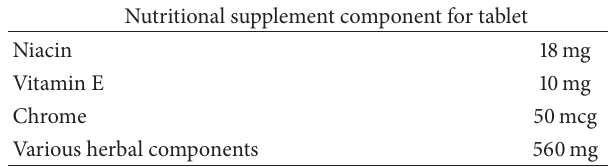
Table 1: Dietary supplement composition. Nutritional supplement component for